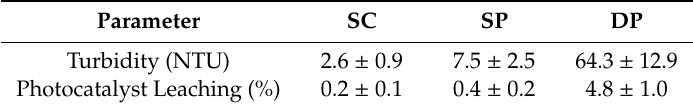
Table 2. Leaching percentage of the immobilized photocatalytic membranes.